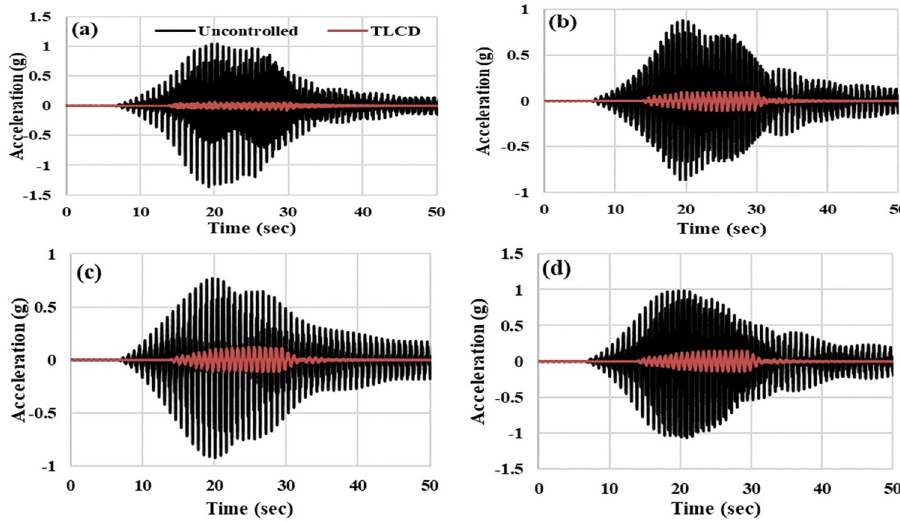
Fig 11. Acceleration time history responses of the MDOF structure equipped with and without TLCD at resonant loading, (a) Storey Level -01, (b) Storey Level -02, (c) Storey Level -03, (d) Storey Level -04.